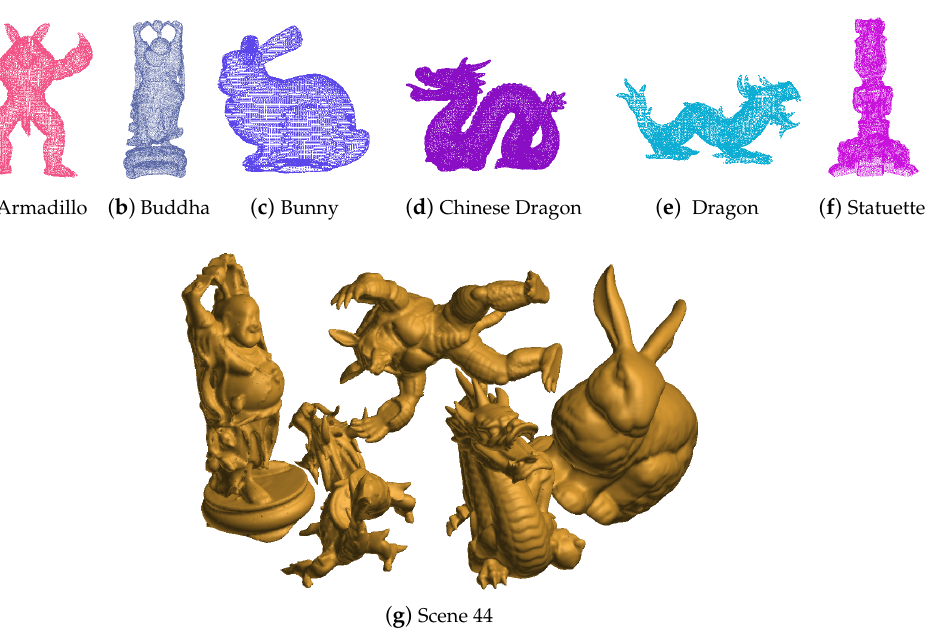
Figure 6. The object models in the Bologna 1